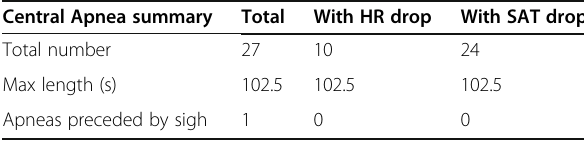
Table 1 Polysomnography; central apnea report Central Apnea